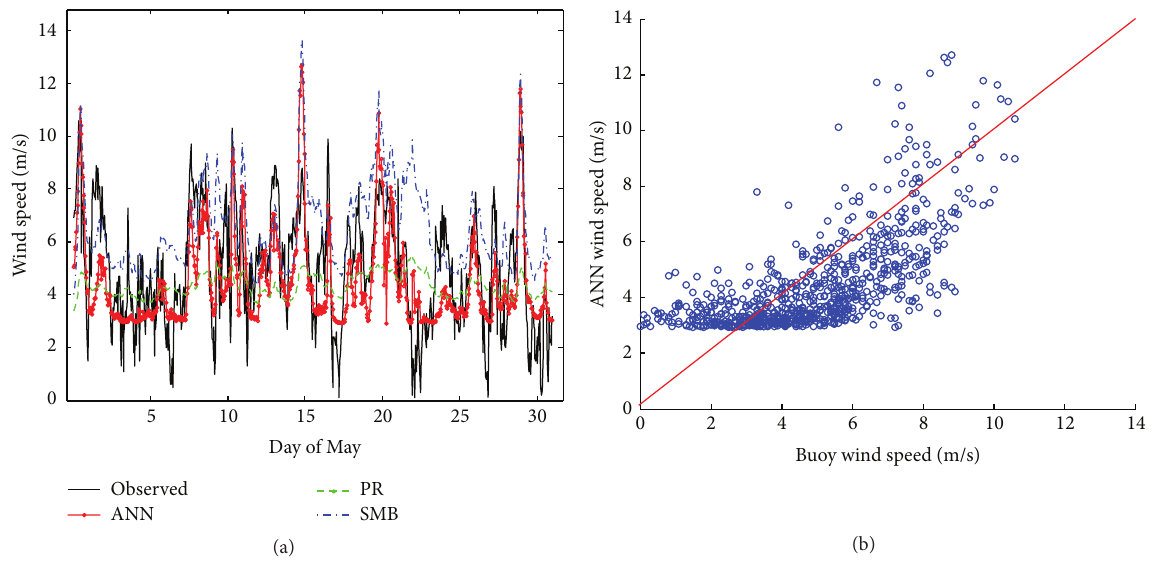
Figure 6: Radar wind speed estimation in May, 2012, by the ANN trained with the buoy data of 2011. (a) Wind speed estimates. (b) Scatter plot by the ANN